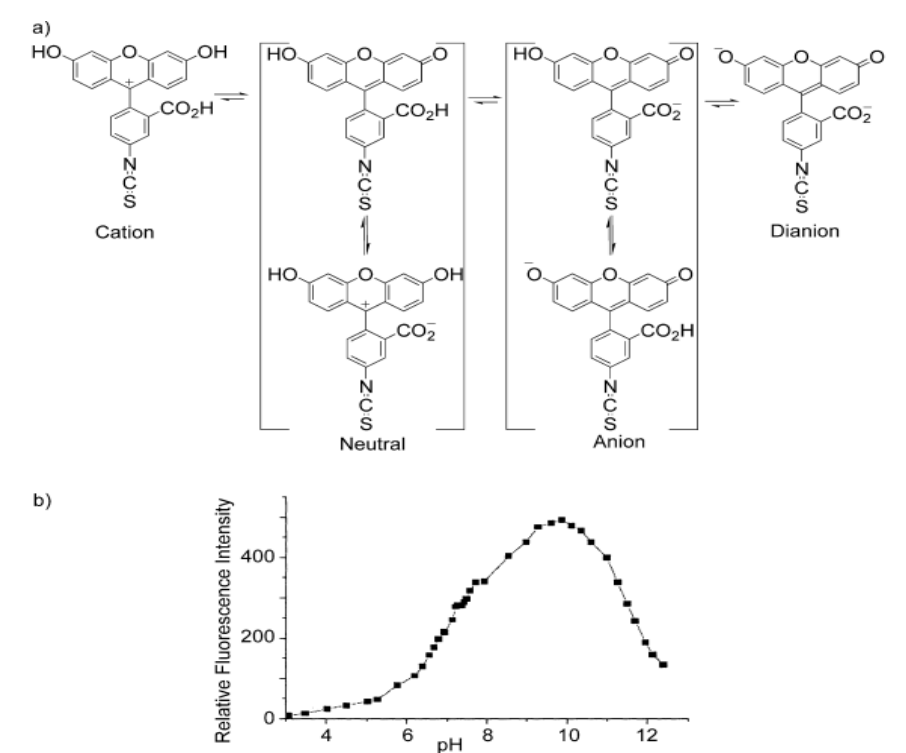
Figure 3. (a) Structure of fluorescein isothiocyanate (FITC) at different pH, (b) its relative fluorescence intensity at selected pH values. Reproduced with permission from reference [44], published by Elsevier,